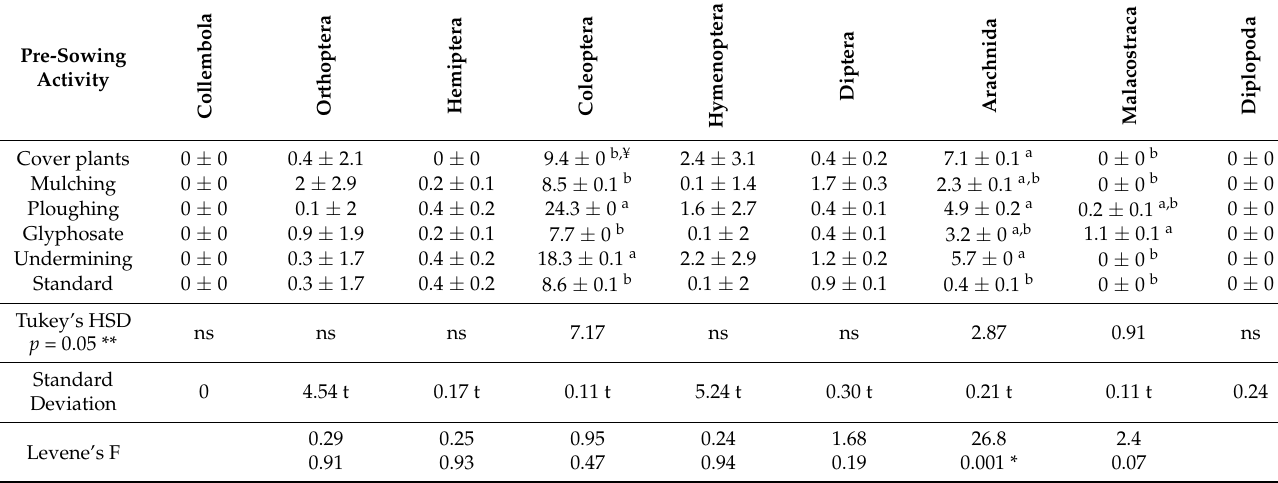
Table 6. Total soil fauna analysed by order/class ( ± SE) collected in June on different tillage systems before sowing.